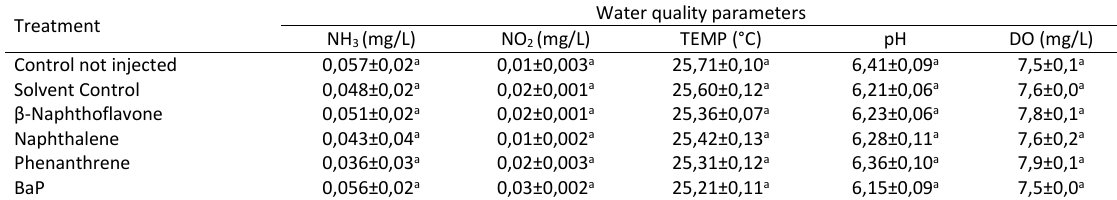
Table 1: Monitoring of physical-chemical water parameters during exposure to PAH in Aequidens metae Treatment